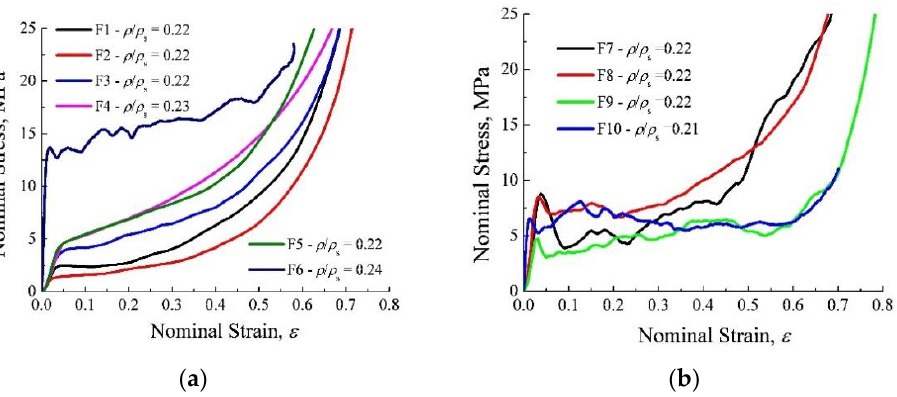
Figure 1. Compression curves for F1, F3, F5, F7, F9 foams processed with titanium hydride TiH 2 and F2, F4, F6, F8, F10 foams produced with calcium carbonate CaCO 3 , all performed with different parent alloys, such as ( a ) pure Al (F1, F2), Al-Si alloy (F3, F4), Al-Mg-Si alloy (F5, F6) and ( b ) Al-Zn-Mg (Sc,Zr) (F7, F8), Al-Zn-Mg (F9, F10).